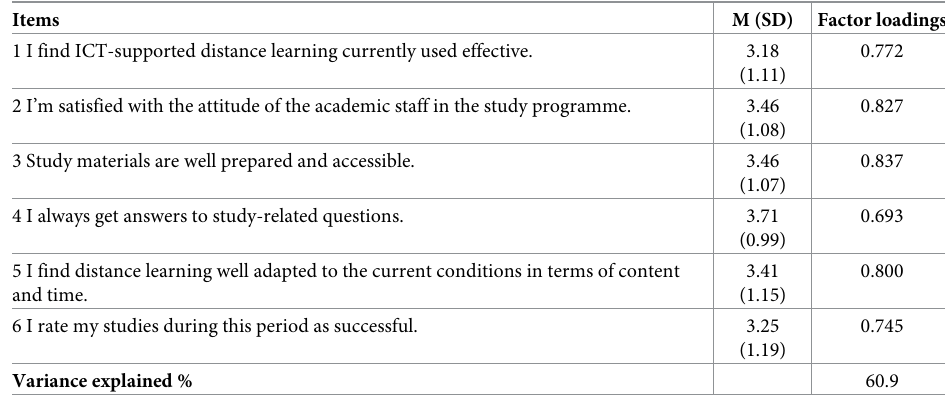
Table 3. Descriptive statistics and factor loadings of the learning satisfaction scale. Items